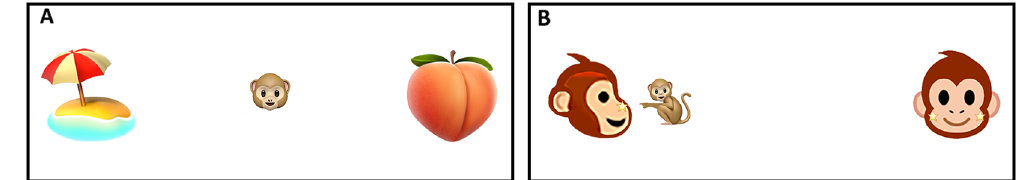
Figure 2. Example screens from the CROWN Game. ( A ) An example stimulus presentation screen of the English phoneme perception task. ( B ) Feedback following choice of target image in the Mandarin phoneme perception